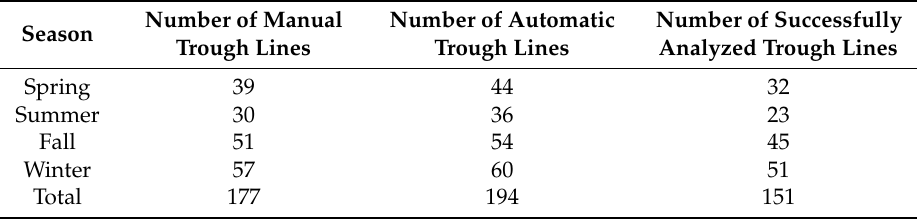
Table 1. Statistical results of the trough line analysis.